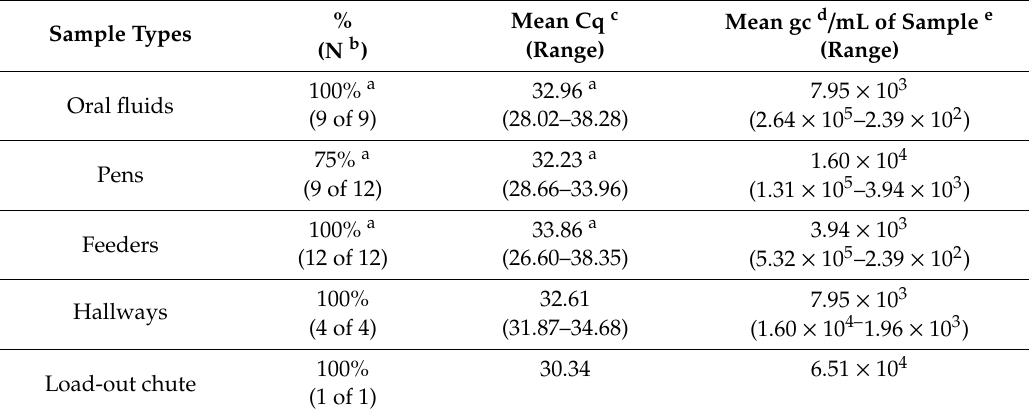
Table 1. Aggregated PoAstV3 detection frequency and RT-qPCR mean Cq and range in di ff erent sample types of the pilot